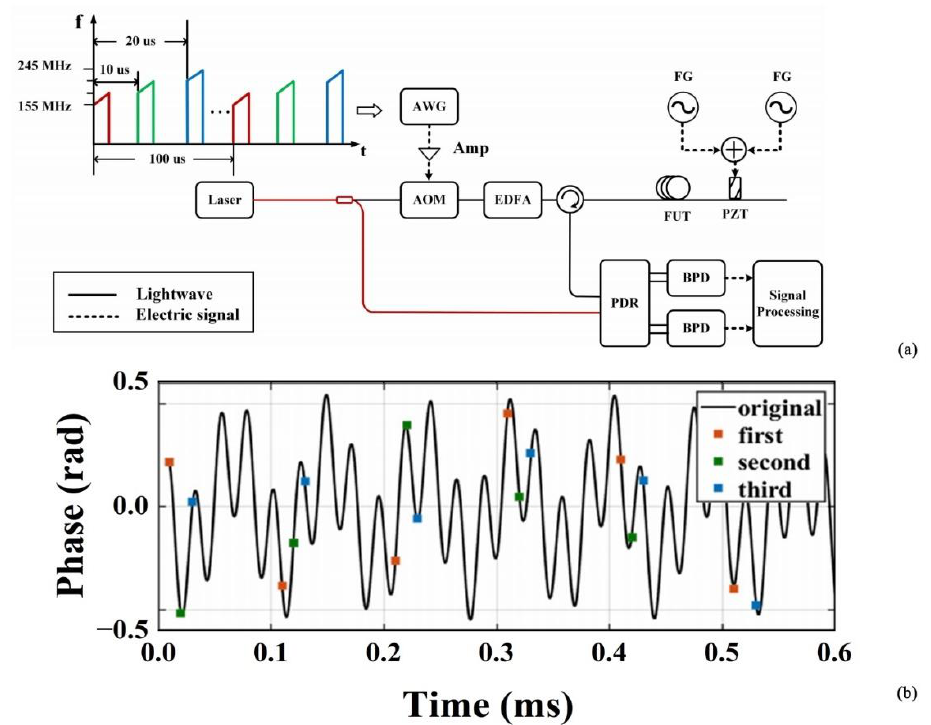
Figure 14. ( a ) Experimental setup; red is polarization-maintaining fiber. ( b ) Time domain recovered waveform of vibrations [60].